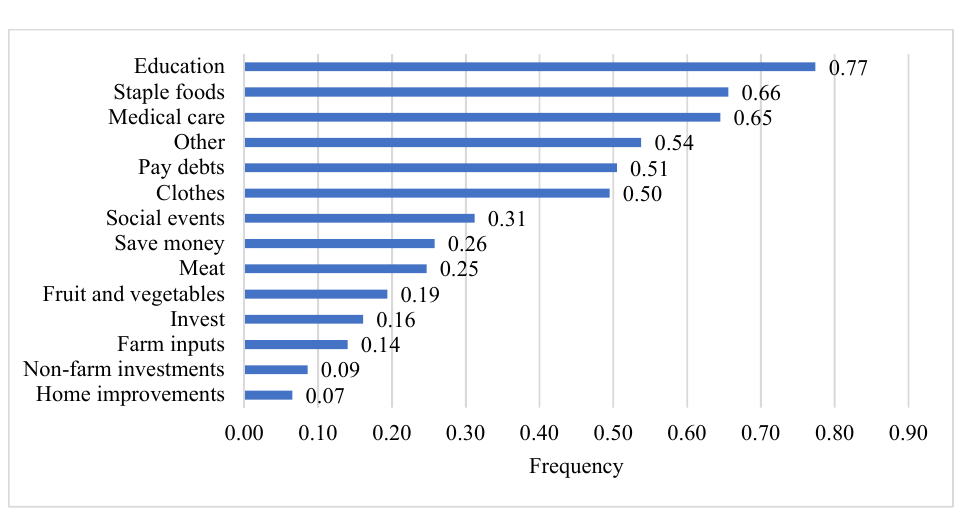
Figure 5. Locations Where Women Sell Instant Flours.